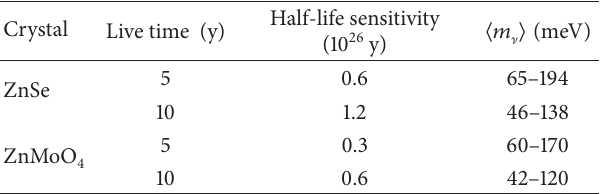
Table 3: LUCIFER half-life background-fluctuation sensitivity in 5 or 10yr at 90% C.L., calculated using (5), and the corresponding ranges of the Majorana neutrino mass, calculated considering the most recent NME [71–77]